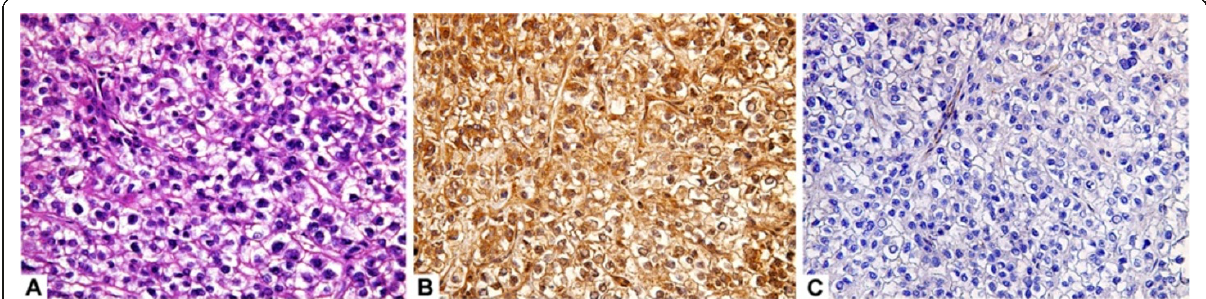
Figure 2 A case of hepatocellular carcinoma (clear cell type) (A, H&E,original magnification x400) with strong and diffuse arginase-1 staining (B; immuoperoxidase, original magnification x400) and negative HepPar-1stainig (C; immuoperoxidase, original magnification x400).